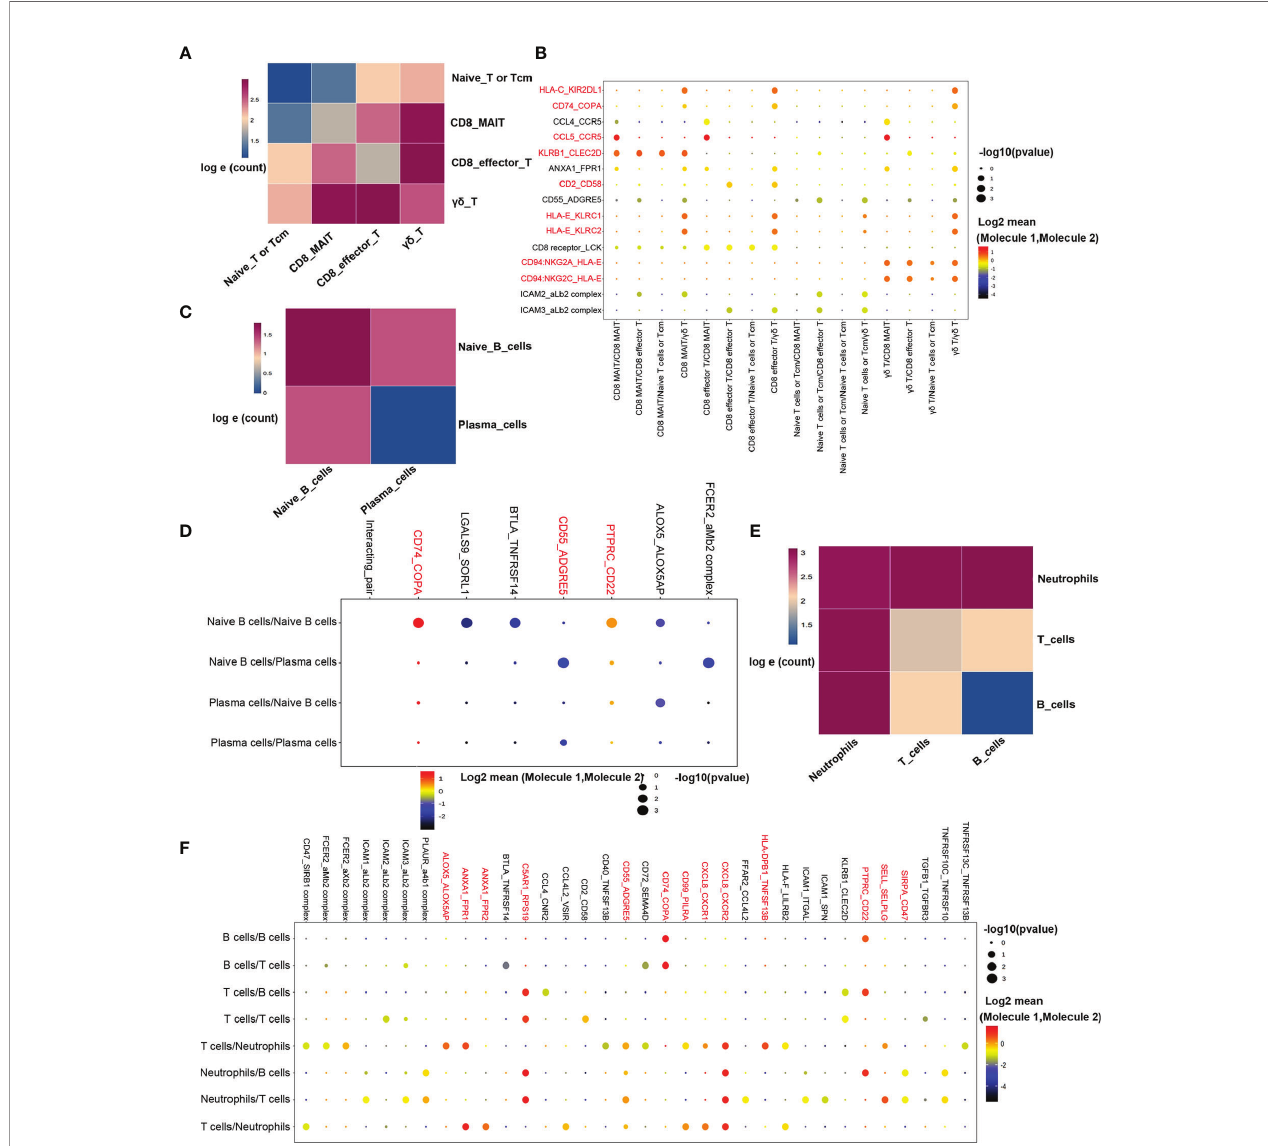
FIGURE 8 | Possible ligand-receptor interactions between different cell types in PBMCs in patients with cABMR. (A) Schematic diagram of the strength of ligand- receptor interactions between T cell subsets. The numbers in the legend represent the log e conversion of the logarithm of the ligand between the two cell types. Darker colors indicate more logarithms of the interaction. (B) Representative ligand-receptor signaling axes interactions between T cell subsets. The size of the dot represents the expression proportion, and the color depth represents the average expression amount; (C) Schematic diagram of the ligand-receptor interaction intensity between naïve B cells and plasma cells; (D) Representative ligand-receptor signaling axes interactions between Naïve B cells and Plasma cells; (E) Schematic diagram of ligand-receptor interaction strength between T cells, B cells, and neutrophils; (F) Representative ligand-receptor signaling axes interactions between T cells, B cells, and